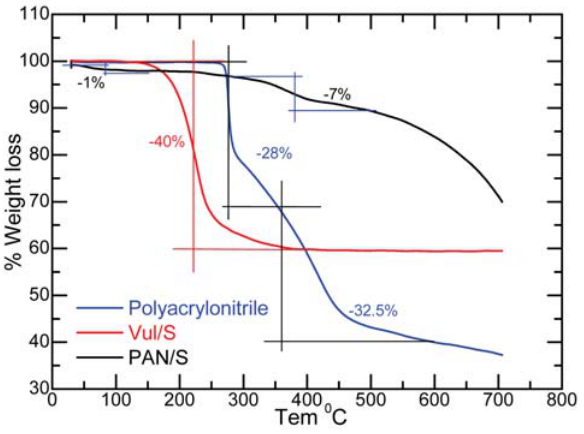
Figure 1. TGA plots of PAN (blue), carbon/S (red) and PAN/S composite (black).